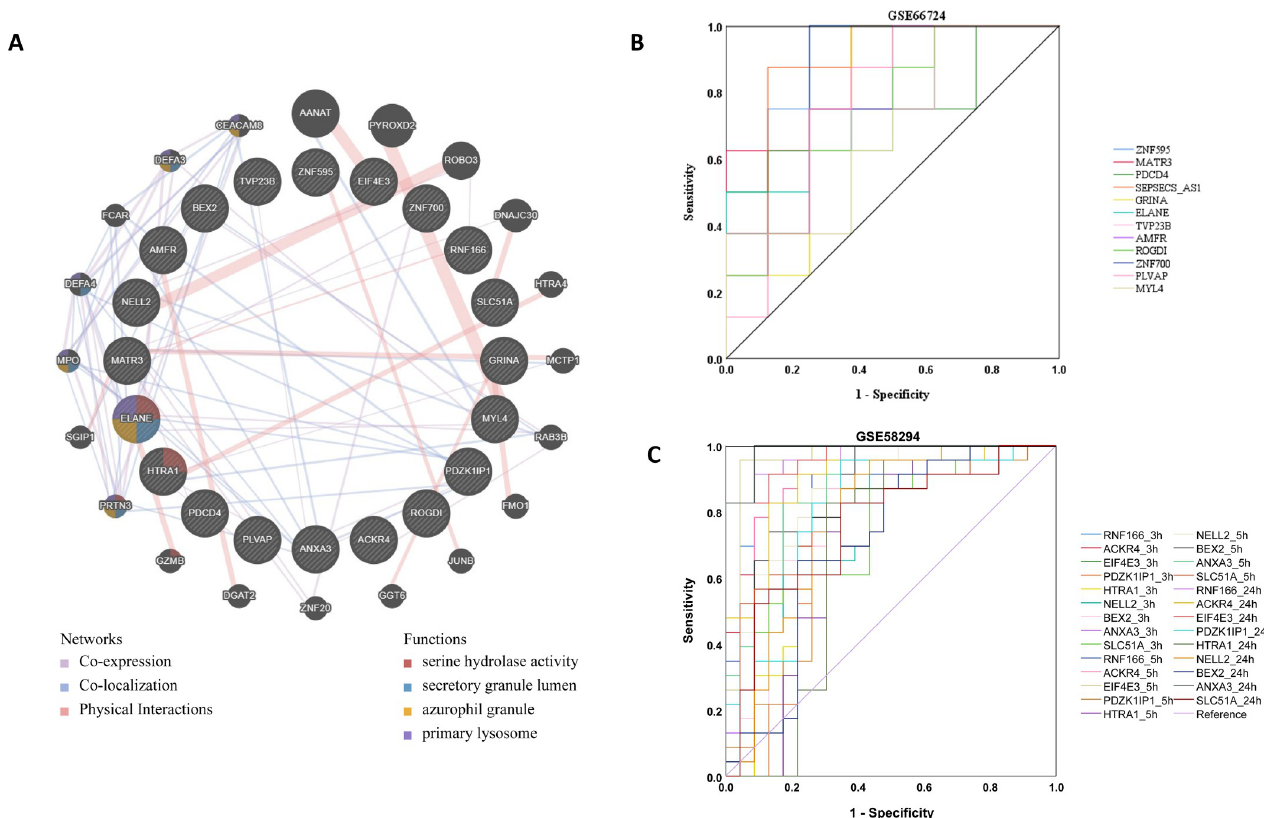
Fig 7. Enrichment analysis of key modules. Gene ontology enrichment analysis in DEG1 (A), DEG2 (B), and DEG3 (C). The significance of enrichment gradually increases from blue to red, and the size of the dots indicates the number of genes contained in the corresponding pathway. ROC curves of hub genes in GSE66724 (D) and GSE58294 (E) were